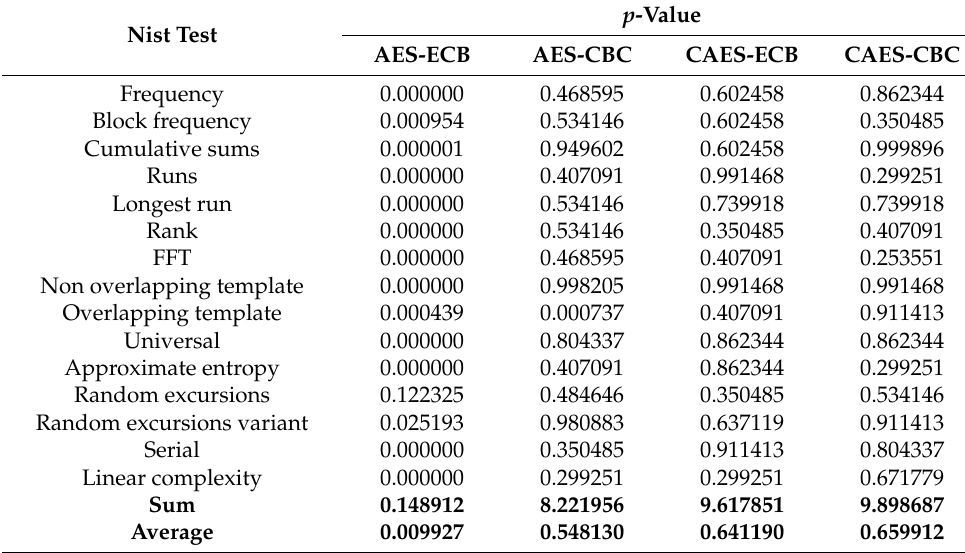
Table 1. National Institute of Standards and Technology (NIST) randomness test.